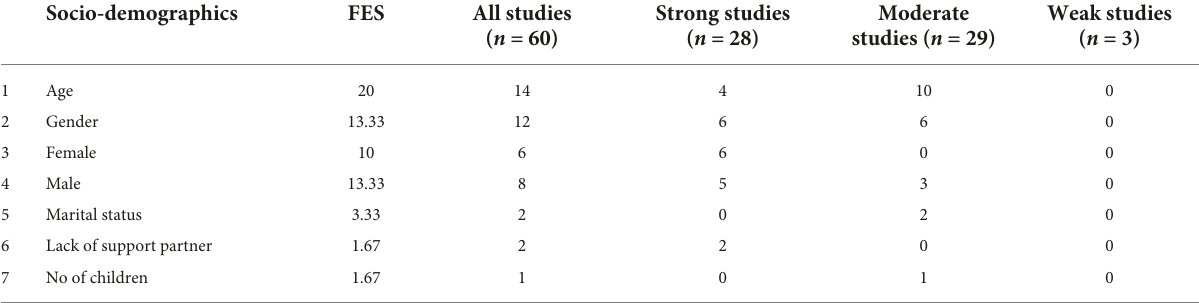
TABLE 6 Study outcomes socio-demographics [ p -values are calculated according to Fisher exact (Freeman and Julious, 2007)]. Socio-demographics FES All studies ( n = 60)